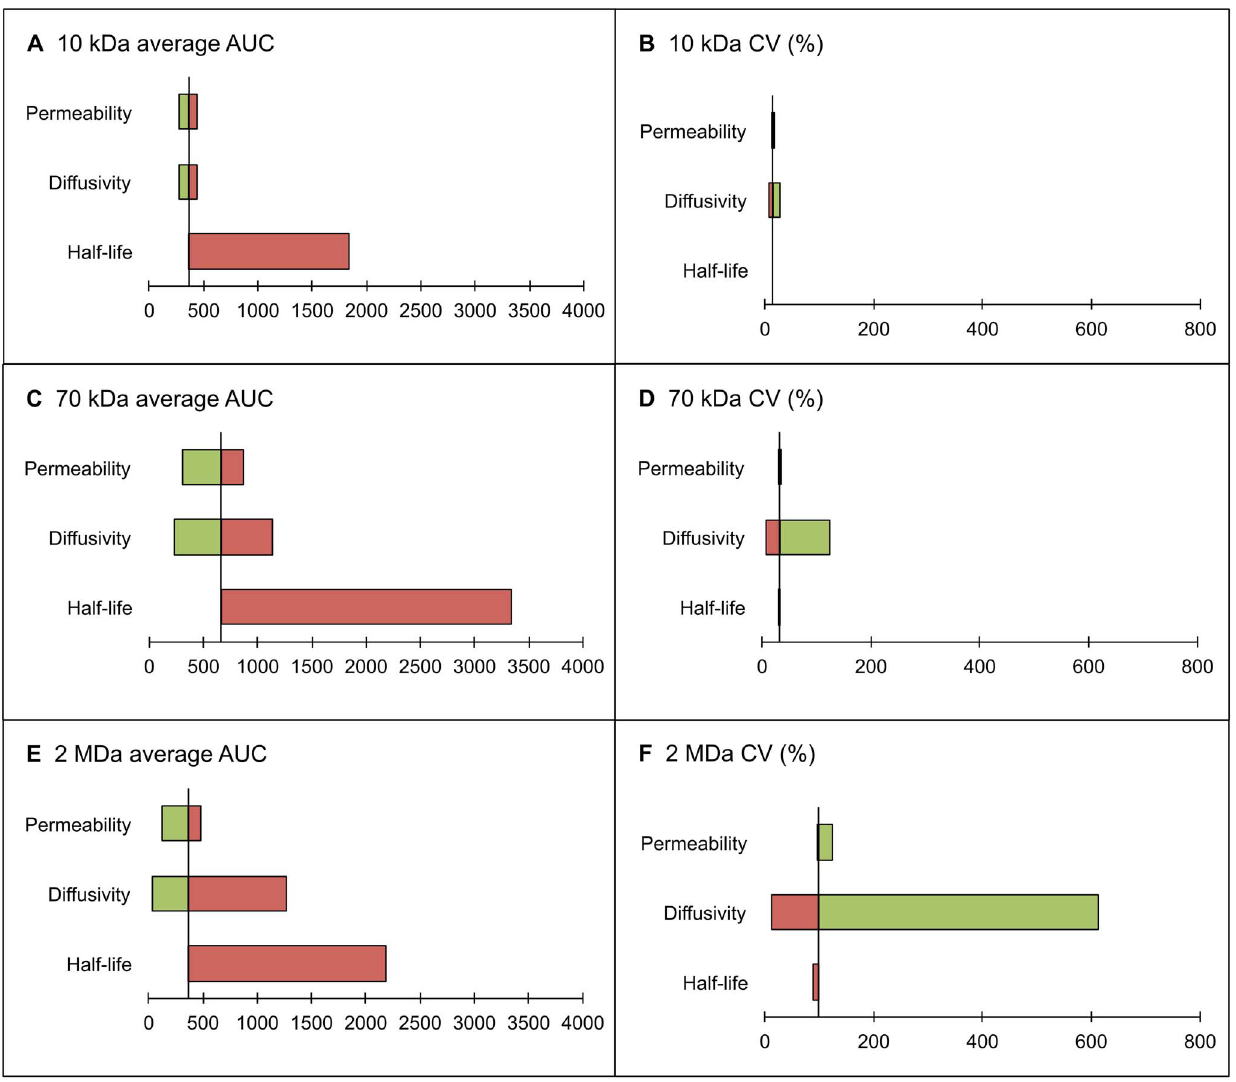
Figure 8. Tornado diagrams displaying the impact of carrier characteristics on the spatial distribution of accumulative exposure. The tornado diagrams of the impact of vascular permeability, interstitial diffusivity and plasma half-life time of carriers on the spatial distribution of accumulative exposure (up to 0 : 5% C max ). The average AUC and CV of the AUC distribution for 10-kDa dextran are presented in subfigures A and B. The corresponding diagrams for 70-kDa and 2-MDa dextrans are contained in subfigures C–D and E–F, respectively. The high and low values of the parameters correspond to the highest and lowest values contained in Tables 2, 3, 4, and are illustrated in red and green bars, respectively.